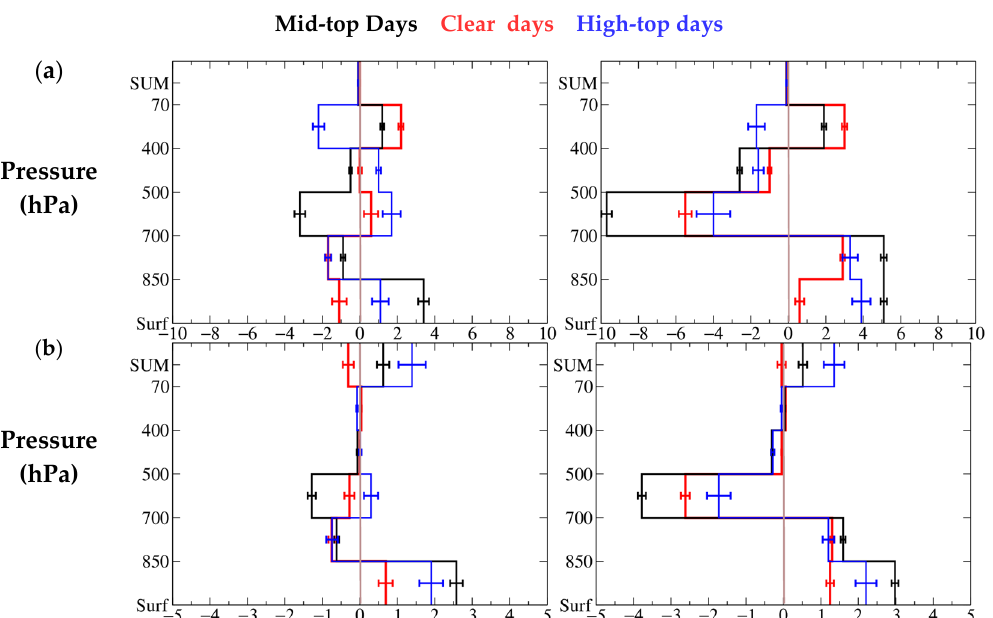
Figure 12. ( a ) mean vertical profile of horizontal mass flux in kg/m 2 /s. ( b ) mean vertical profile of horizontal water vapor flux rate value in kg/m 2 /d and at the top of Y axis the value integrated over the whole vertical column (surface to 70 hPa; SUM). Average over the JJAS period for mid-top days (black), clear days (red) and high-top days (blue). Statistical uncertainty of the mean values (horizontal bars). Information is given for West-Sahara (left column) and Hoggar (right column).